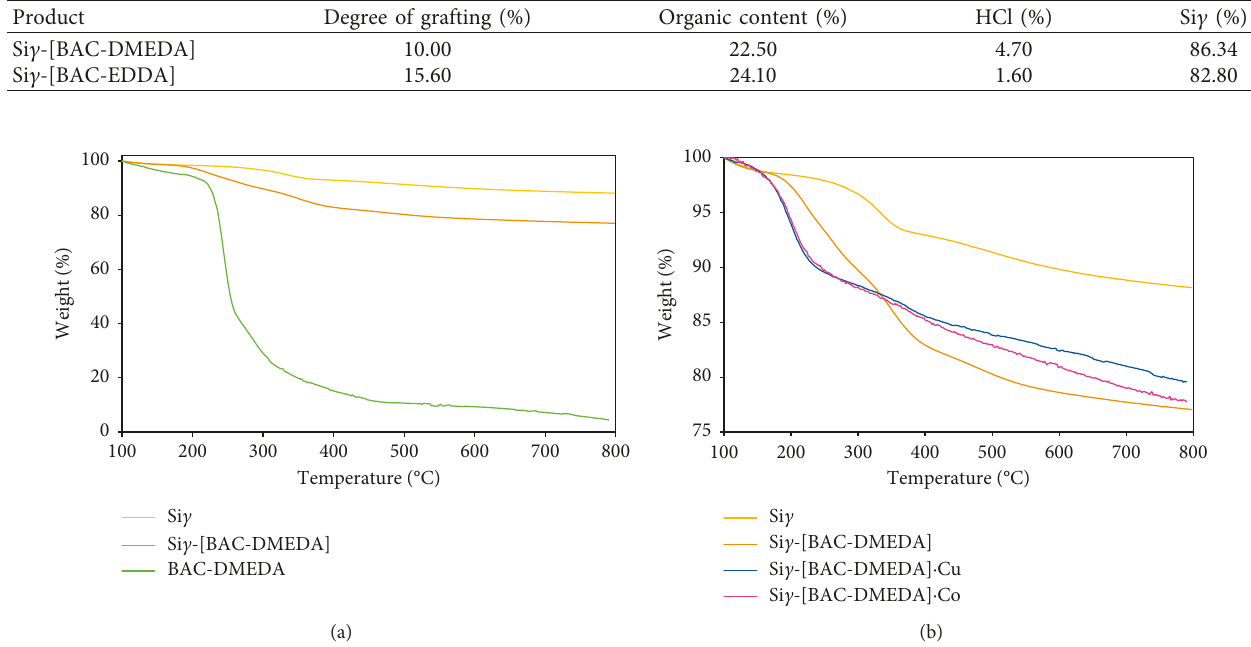
Figure 3: TGA traces of aminated silica, Si c -[BAC-DMEDA], and linear [BAC-DMEDA] polymer (a) and of aminated silica, Si c -[BAC- DMEDA], Si c -[BAC-DMEDA]Cu, and Si c -[BAC-DMEDA]Co (b) obtained at a heating rate of 20 ° C/min under nitrogen atmosphere. Table 3: Surface atomic composition of aminated silica, PAA-grafted silica, and ion-chelated hybrid silica. Surface atomic composition Sample